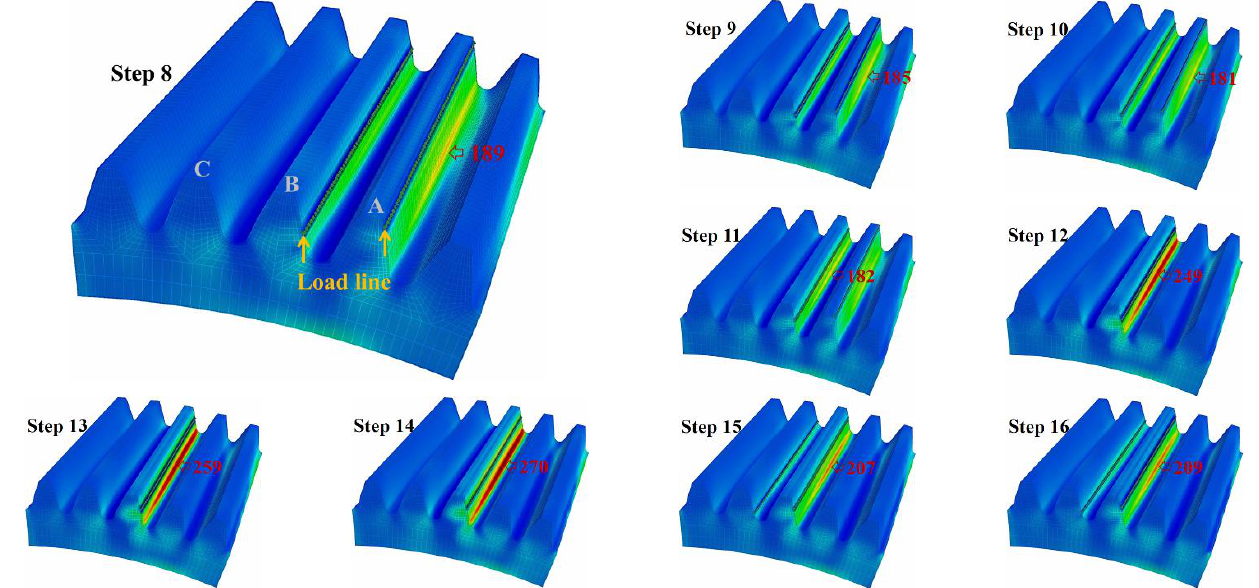
Figure 12. Evolution process of tooth root stress distribution on sun gear.